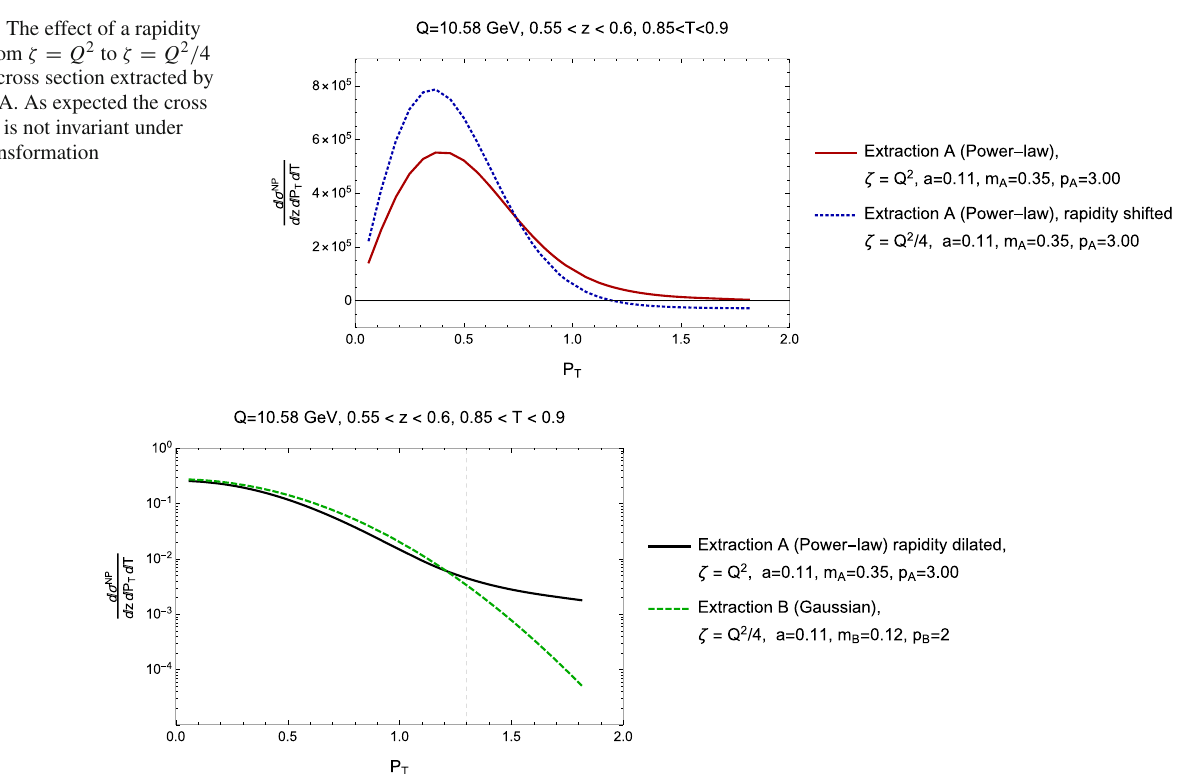
Fig. 10 Left panel: non perturbative contribution to the LO cross sec- tion, corresponding to the same choice of rapidity cut-off. The solid black line represents the extraction of Group B, while the dashed green line is obtained from the extraction of group A by applying a rapidity